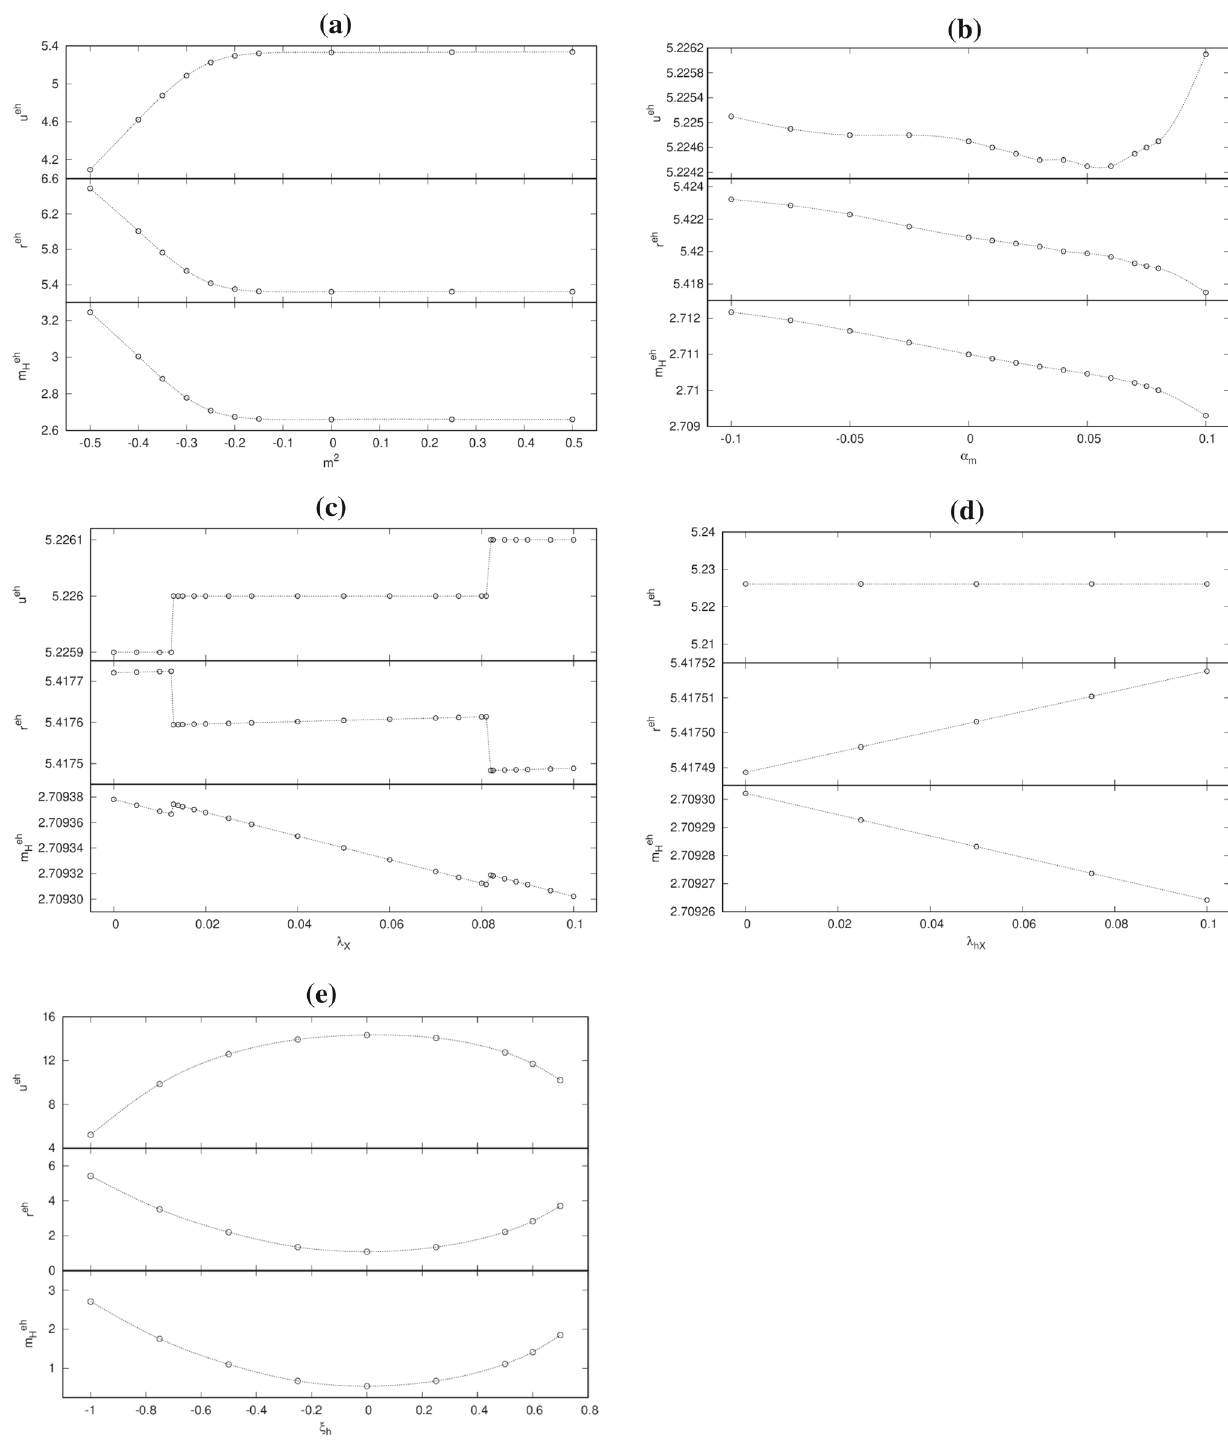
Fig. 12 The u -locations of the event horizons, u eh , radii, r eh , and masses, m eh , of black holes formed during the gravitational collapse H with one non-vanishing scalar–gravity coupling constant as functions